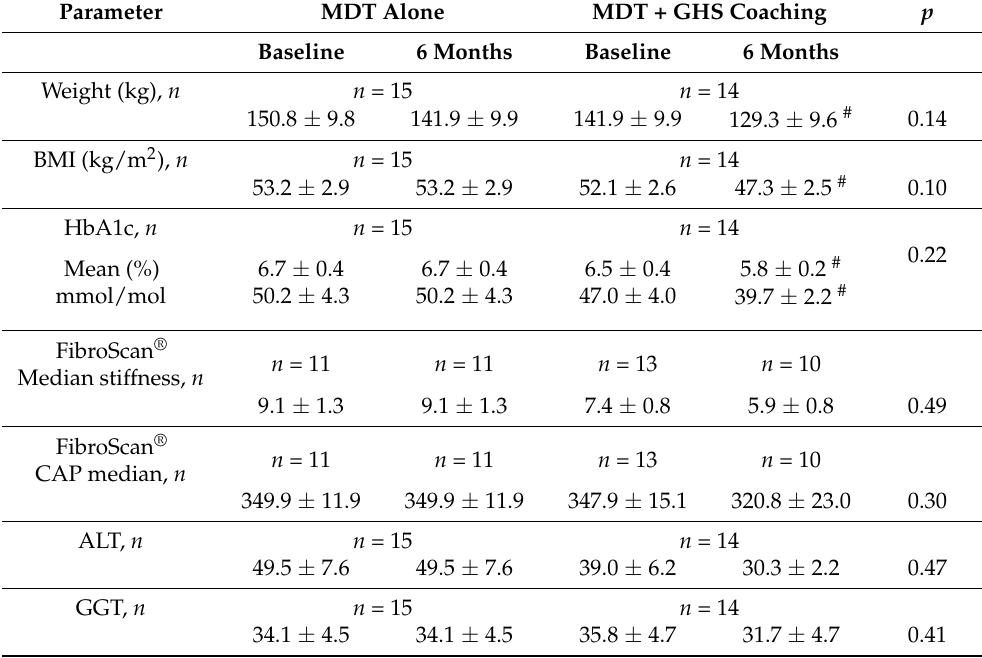
Table 2. Participant risk factors at baseline and 6 months